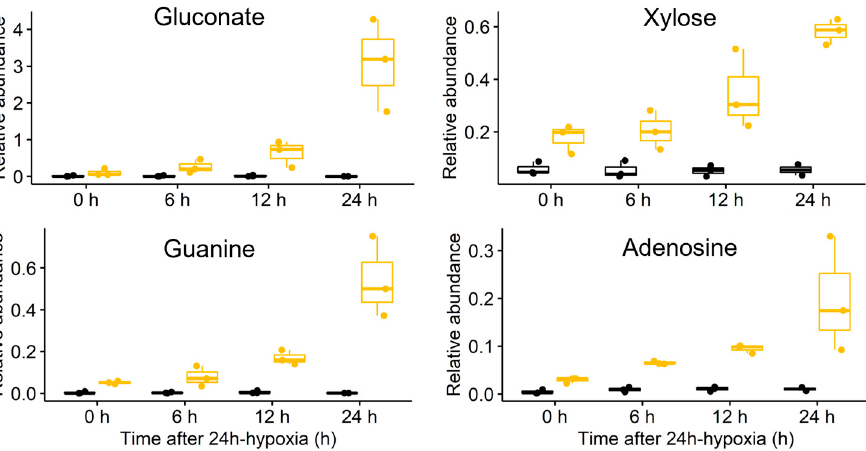
Figure 7. Metabolites that keep accumulating during the post-hypoxia reoxygenation. Data are presented as box plots (center line at the median, upper bound at 75th percentile, lower bound at 25th percentile) with whiskers extended to the extreme data points ( n = 3).